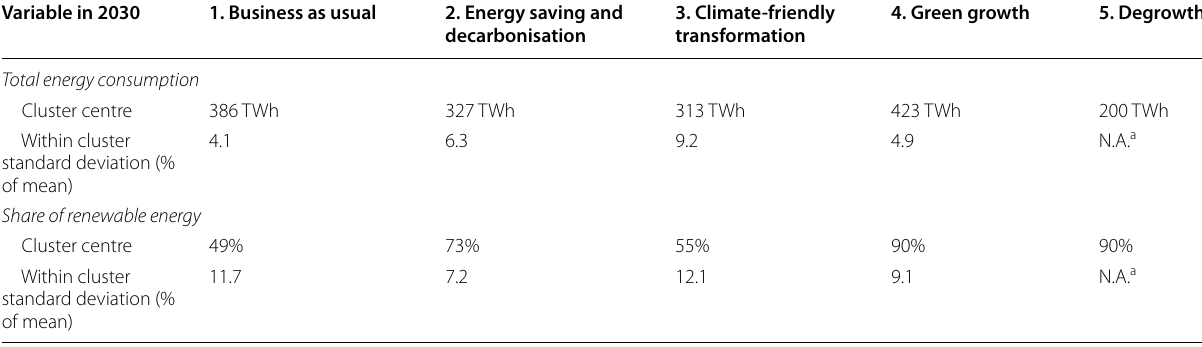
Table 1 The cluster centres in each scenario regarding energy consumption time series